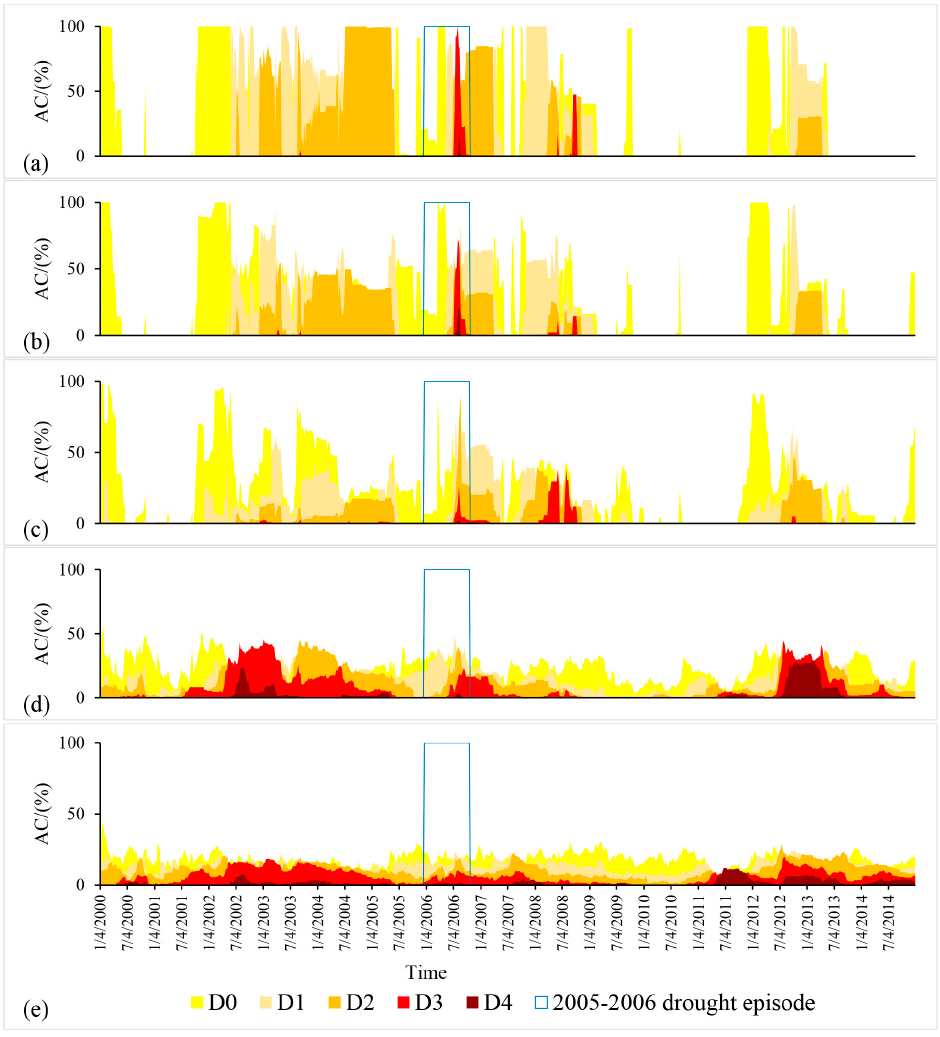
Figure 4. Propagation of areal coverage (AC) of different intensity category droughts over ( a ) Grant county, ND; ( b ) SCCD, ND; ( c ) ND State; ( d ) HPR; and ( e ) the contiguous U.S.